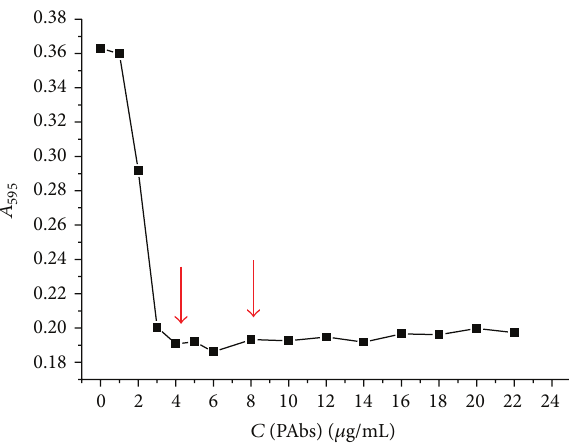
Figure6:ValuesofGNPsopticaldensityat580 nmunderhighionic strength obtained after GNP stabilization by the anti-TC polyclonal antibodies at different concentrations.